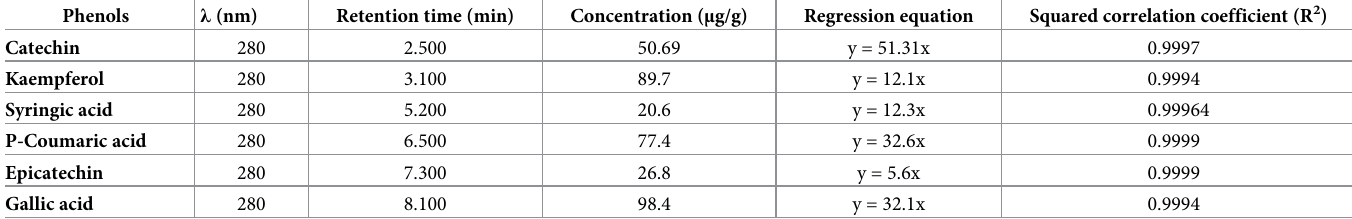
Table 2. Quantitative analysis for MEOAL by